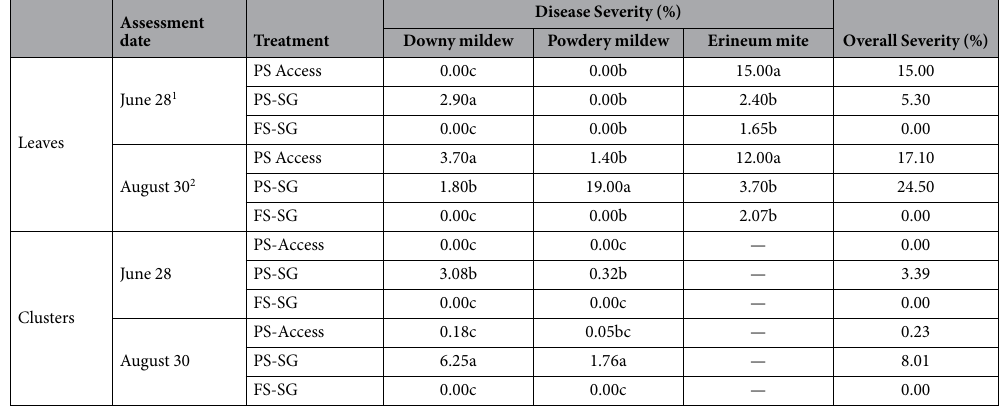
Table 2. Severity (%) of downy mildew, powdery mildew and erineum mite evaluated during disease assessments on June, 28 1 and August, 30 2 . Small letters obtained by Fisher protected Least Significant Difference (LSD). Test show significant differences for P < 0.05. PF = partially sprayed. FS = fully sprayed. 1 BBCH 77 berries beginning to touch; 2 BBCH 89 berries ripe for harvest; °Brix ≅